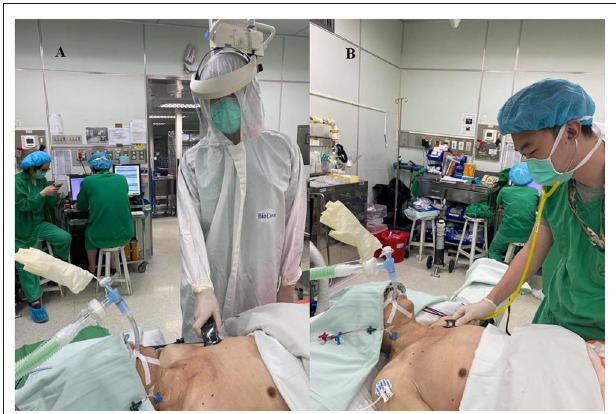
FIGURE 4 | Illustrations of participant anesthesiologist setting. (A) . Illustration of full level C PPE (complying with the requirements of the Occupational Safety and Health Administration) in the electronic stethoscope group. (B) . Regular surgical scrubs and cap, not covering the face or ears in the conventional stethoscope